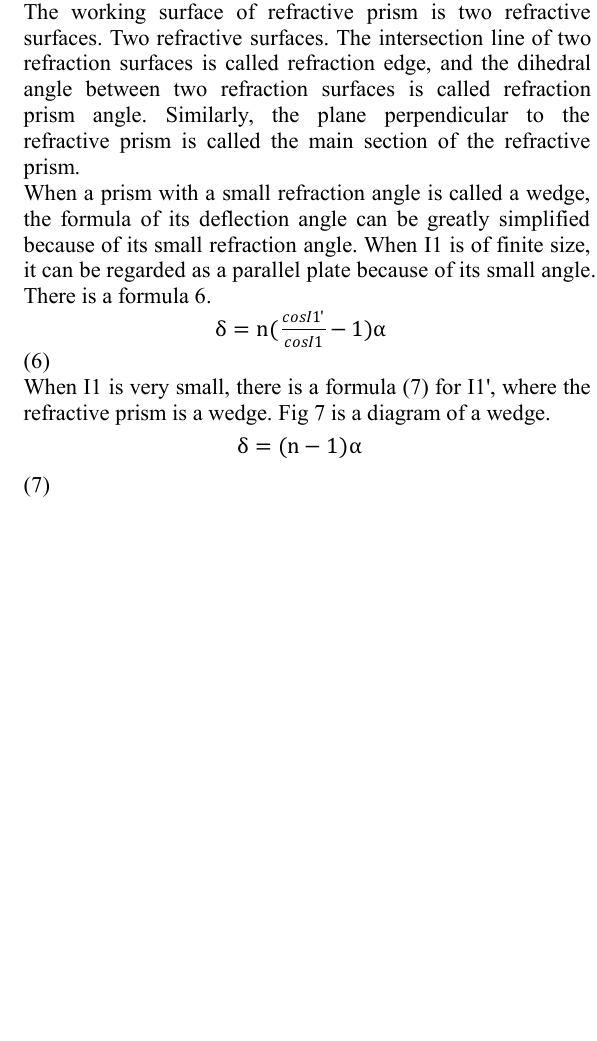
Figure 6. Diagram of double optical wedges 3.5Design Of Optical Wedge A wedge is a refractive prism with the ability to deflect light.